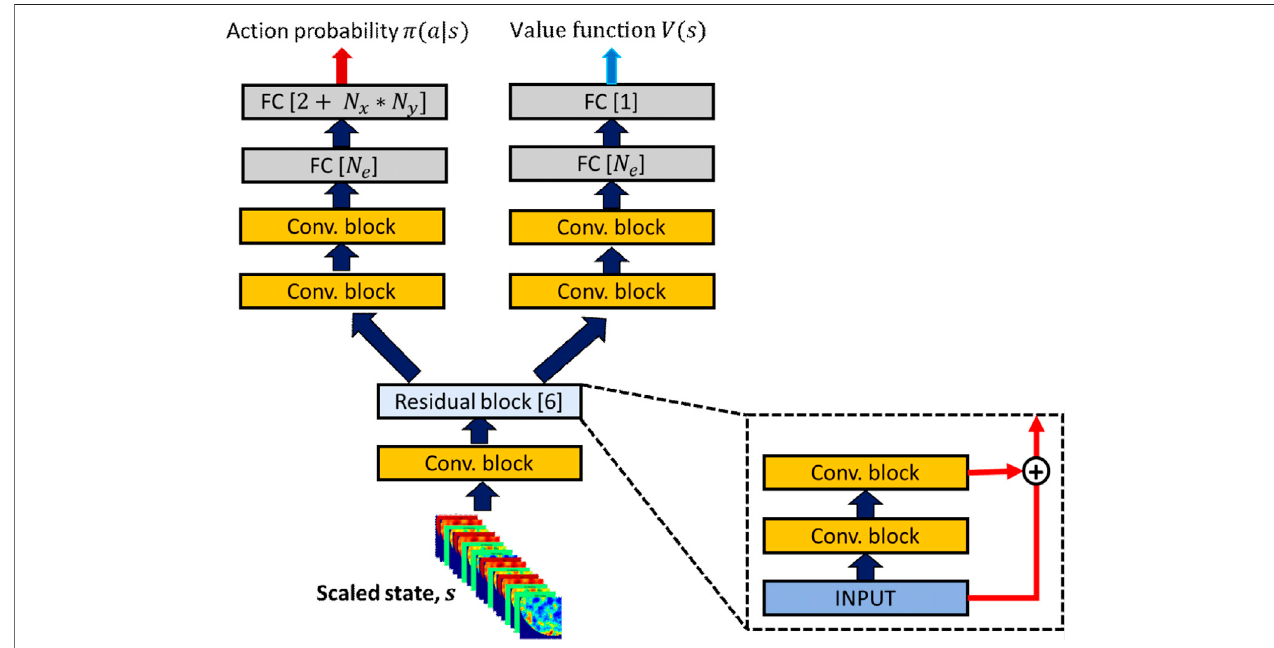
FIGURE 2 | The neural network architecture that de fi nes the policy and value functions. The “ conv ” block represents a convolutional neural network (CNN) layer followed by recti fi ed linear unit (ReLU). FC ( N e ) represents a fully connected layer with N e neurons.